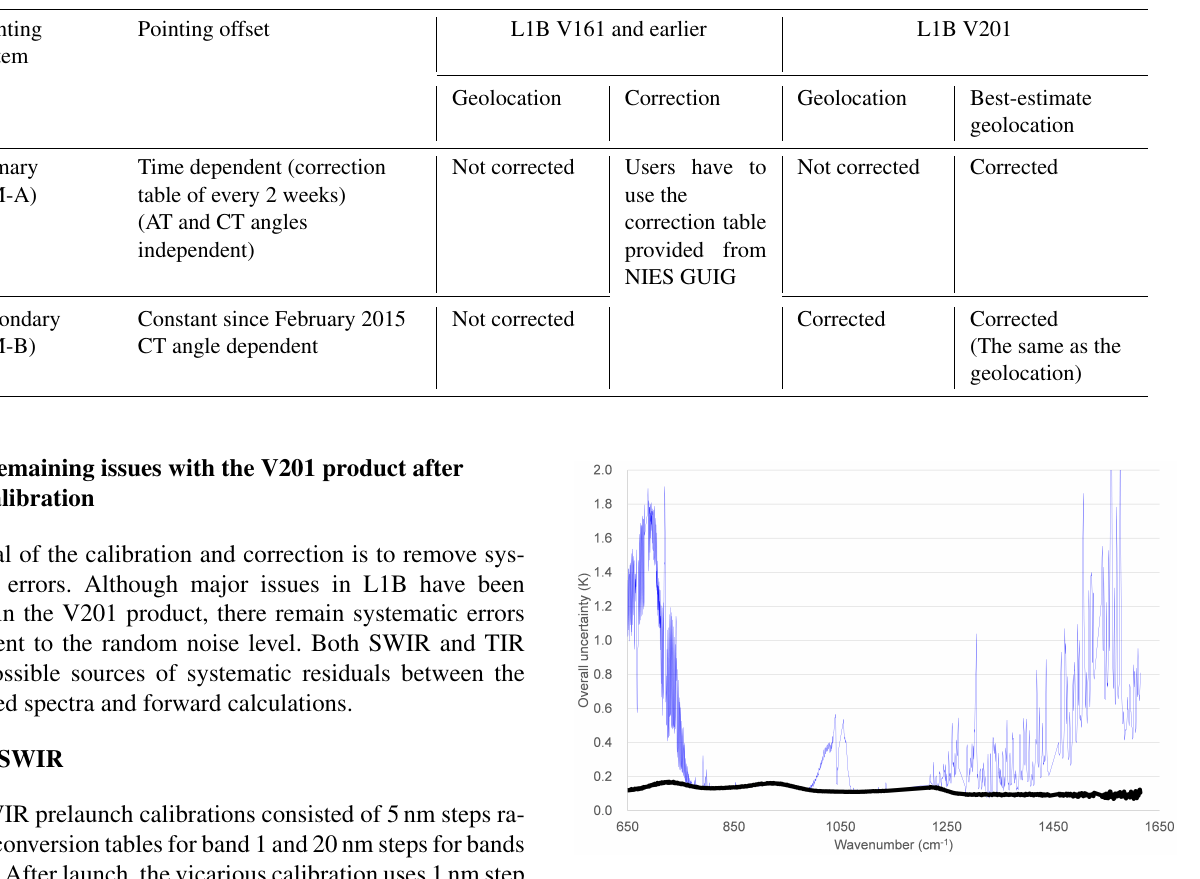
Figure 13. Estimated calibration uncertainty by adding systematic bias error in case of viewing nadir (06:19:10UTC, on 23 Decem- ber 2010) (solid line) and 280K BB target (bold